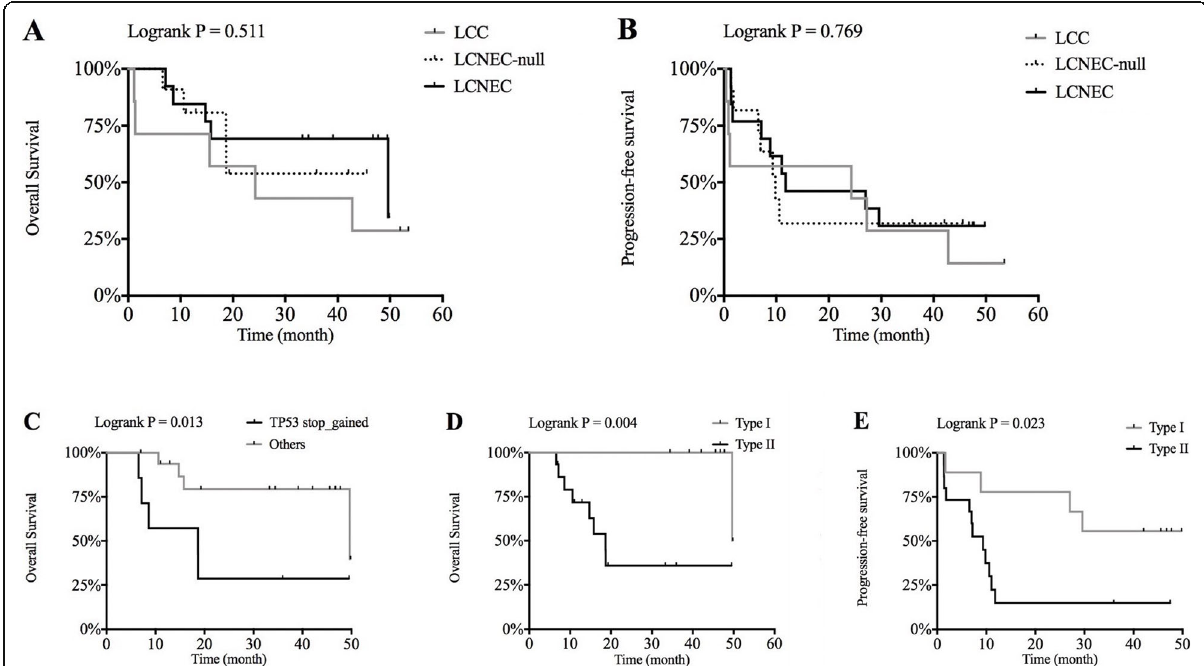
Fig. 6 Survival analysis of different groups. A Overall survival of LCC, LCNEC-null and LCNEC. B Progression-free survival of three groups. C Stop_gained mutation pattern of TP53 vs other alterations in LCNEC-null and LCNEC. D Overall survival of two types among LCNEC-null and LCNEC. E Progression-free survival of two types among LCNEC-null and LCNEC